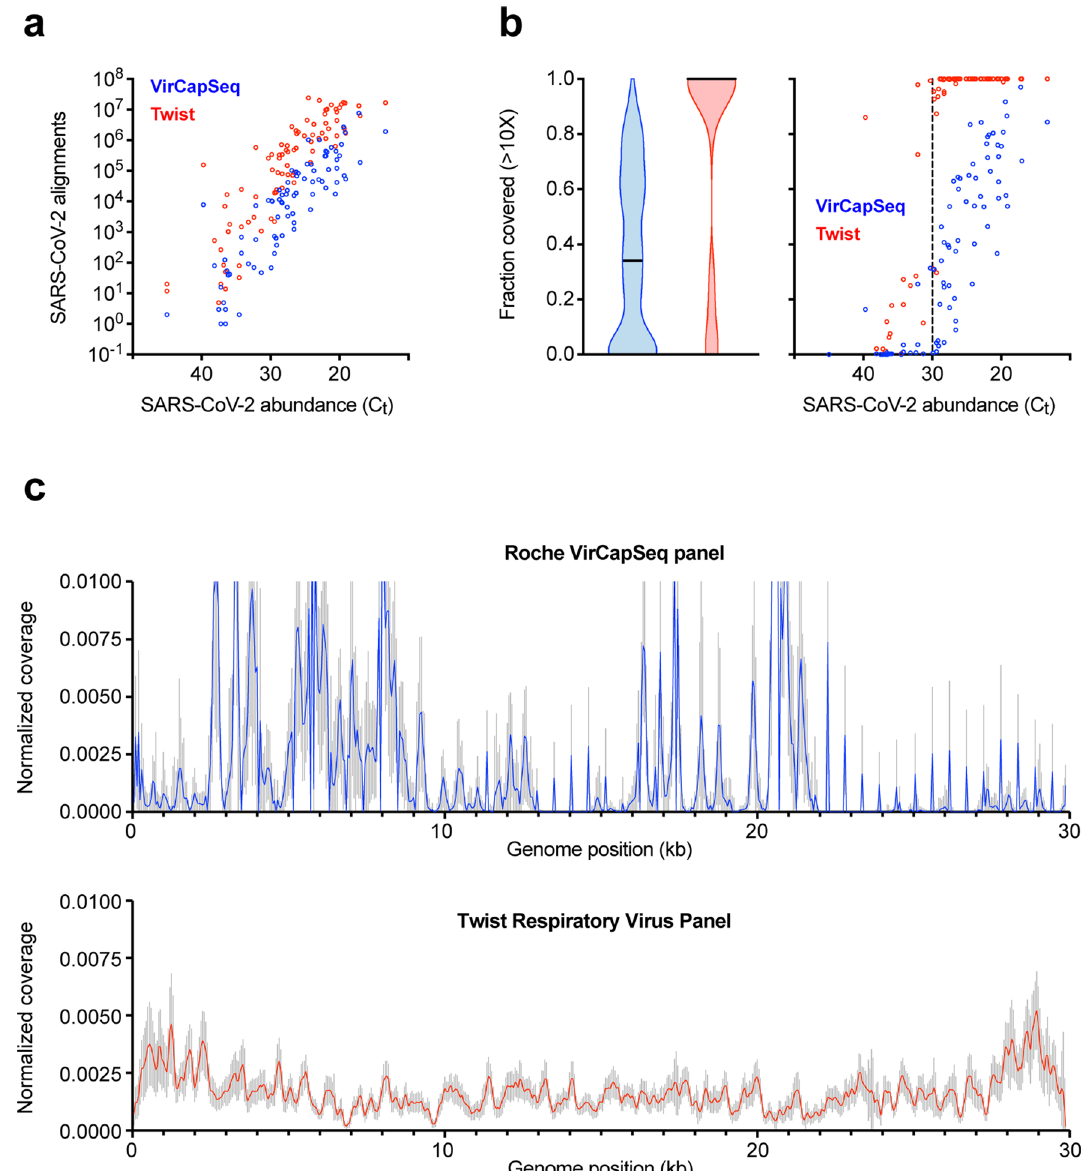
Figure 3. Complete SARS-CoV-2 genome coverage by sequences generated using the Twist Respiratory Virus Panel. ( a ) The number of sequence reads generated by VirCapSeq (blue) and Twist (red) hybrid-capture sequencing, aligned to SARS-CoV-2 in case samples (n = 83) with varying viral load determined by the qRT- PCR cycle threshold (Ct) value. ( b ) The fraction of SARS-CoV-2 genome covered at > 10X depth. Violin plot (left) shows the distribution of genome coverage in samples sequenced by VirCapSeq (blue) and Twist (red) capture with horizontal line indicating the median fraction of genome covered. Vertical dotted line indicates the Ct 30 border (right). ( c ) Distribution of aligned sequence reads across the SARS-CoV-2 reference genome (MN908947.3) and depth of coverage at each position in the genome (50-bp windows) normalized to the average coverage across the whole genome for a given